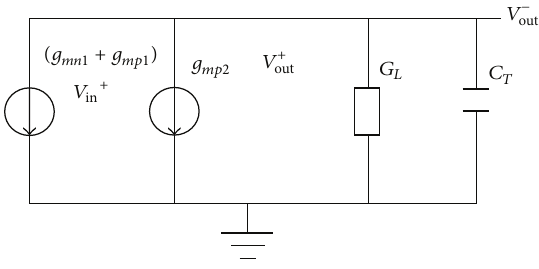
Figure 4: Small-signal equivalent circuit of the half circuit of the delay cell for frequency analysis.